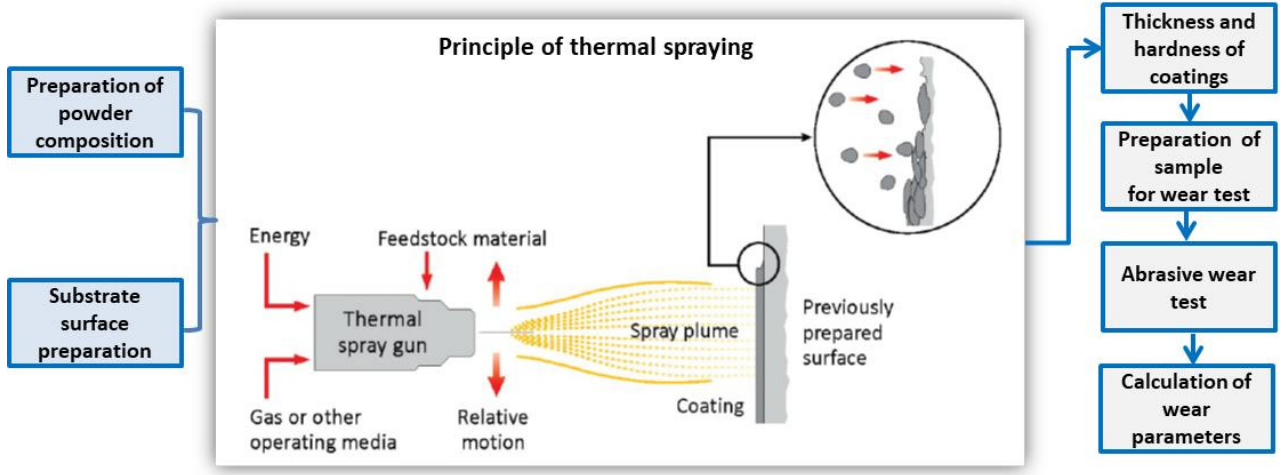
Figure 1. Scheme of preparation and research of HVOF-coatings.